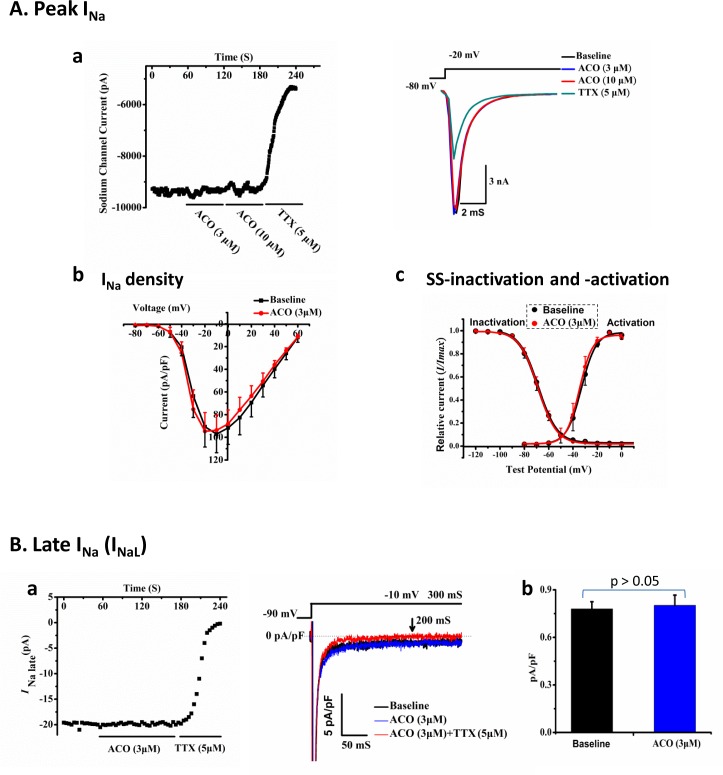
Effects of ACO on sodium currents in hiPSC-CMs.(Aa) A representative time course and corresponding traces of the peak INa recorded in a hiPSC-CM showing the effect of ACO and TTX. (Ab) The I-V curve showing peak INa density in hiPSC-CMs. n = 7. (Ac) The SS-inactivation and -activation curves. n = 7. (Ba) A representative time course and the corresponding traces of late INa (INaL) recorded in a hiPSC-CM showing the effects of ACO and TTX. (Bb) A bar-graph showing the average densities of the INaL (at 200ms) recorded in hiPSC-CMs treated with 3 μM ACO. n = 7.